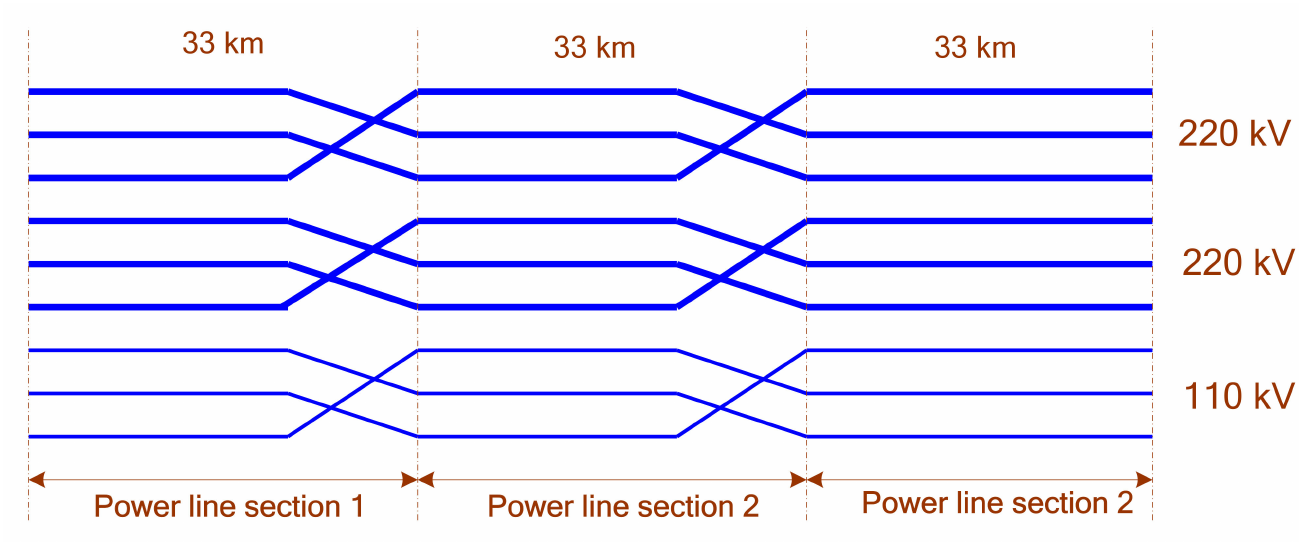
Figure 9. Coordinates of conductors: ( a ) three-circuit transmission line; ( b ) corridor of three transmis- sion lines.